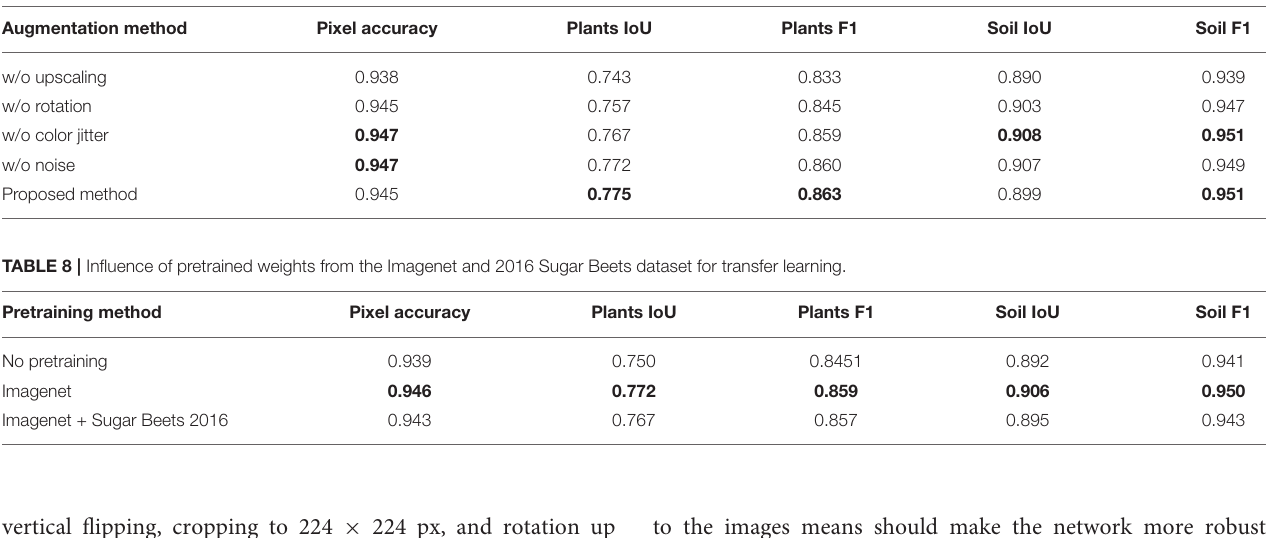
TABLE 7 | Data augmentation ablation study.